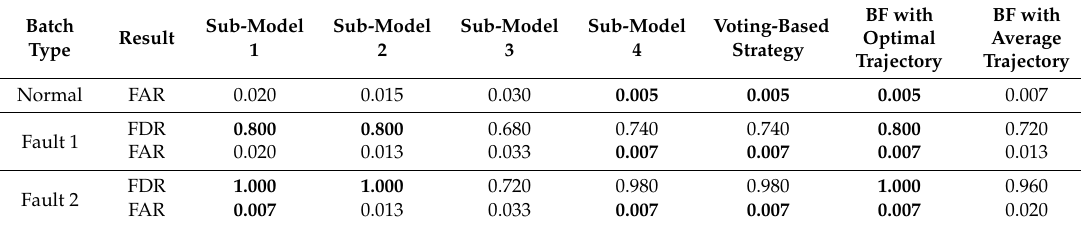
Table 3. FAR and FDR under different ensemble strategies in numerical example.